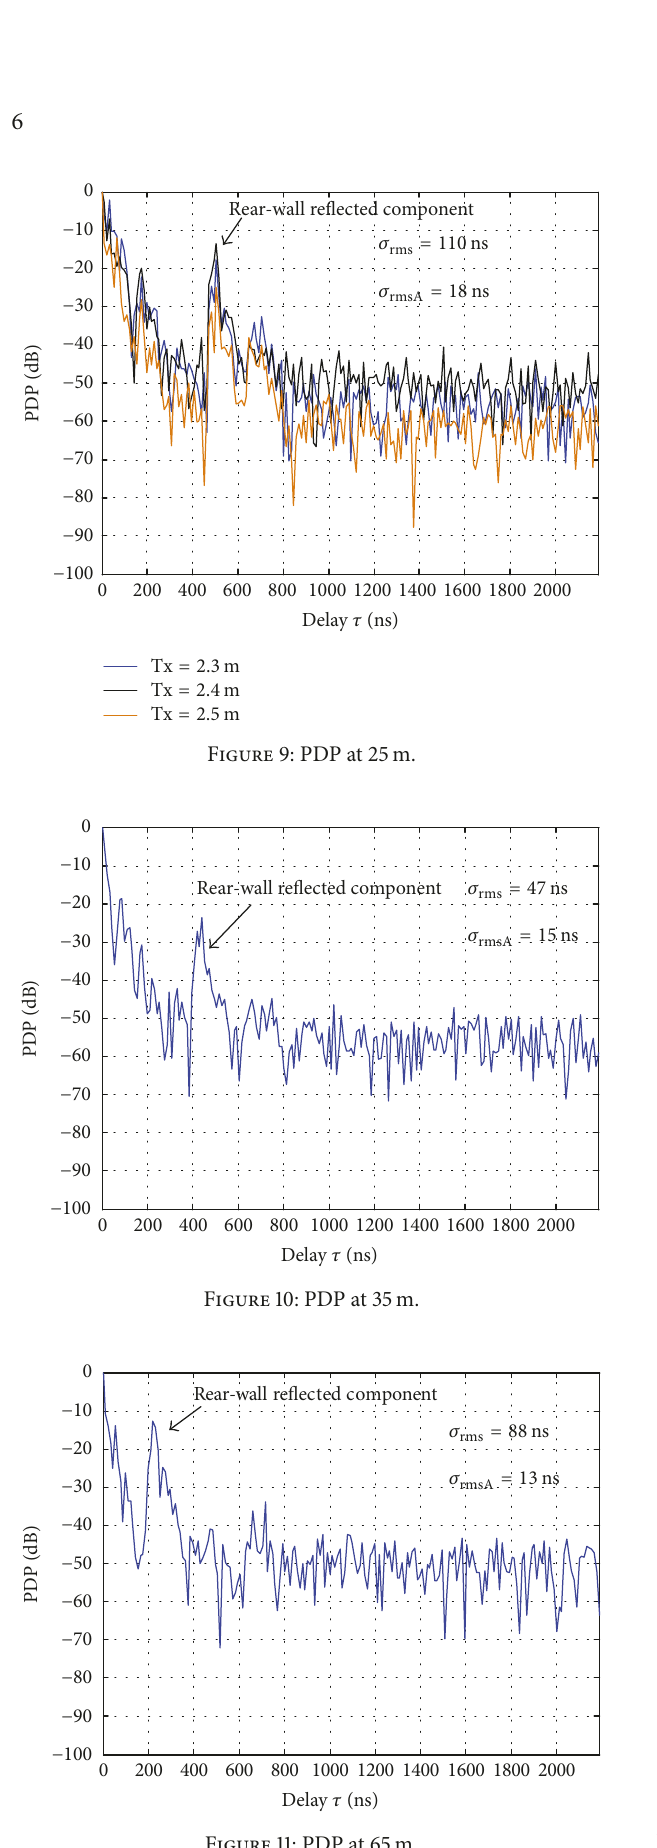
Figure 11: PDP at 65 m.